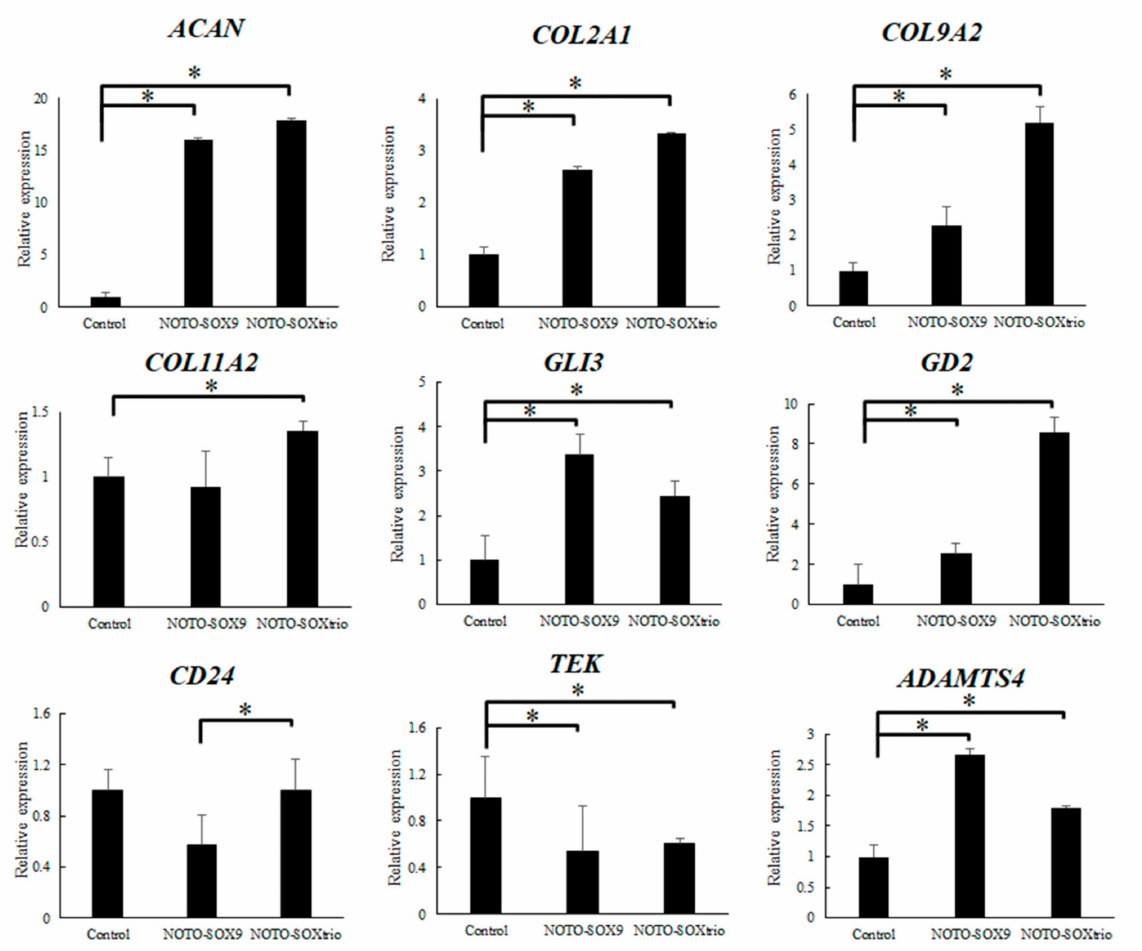
Figure 1. Transcriptional profiling of NHDFs. Error bars denote the mean ± SD. * p < 0.05 (Mann– Whitney